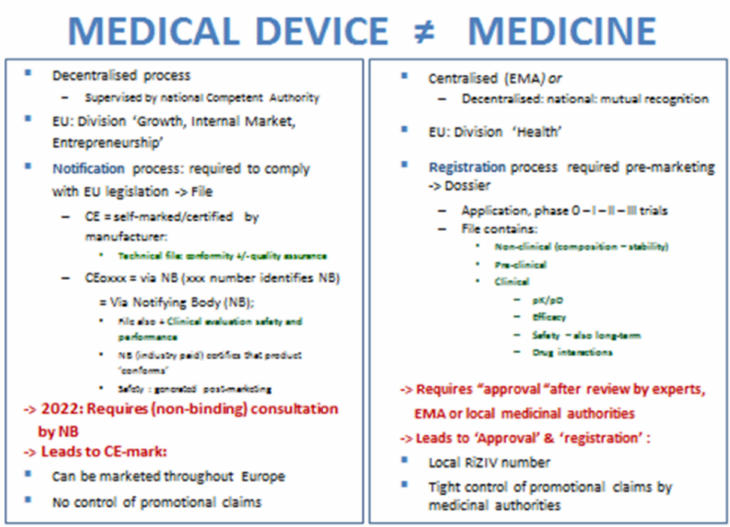
Figure 1. Differences in regulations between medical devices and medicines in the European Union (definition of performance: “the ability of a device to achieve its intended purpose as stated by the manufacturer”; CE = Conformit è Europëeenne; NB: Notifying body; pK/pD = pharmacokinet- ics/pharmacodynamics); EEA = European Economic Area. EMA = European Medicines Agency; EU = European Union